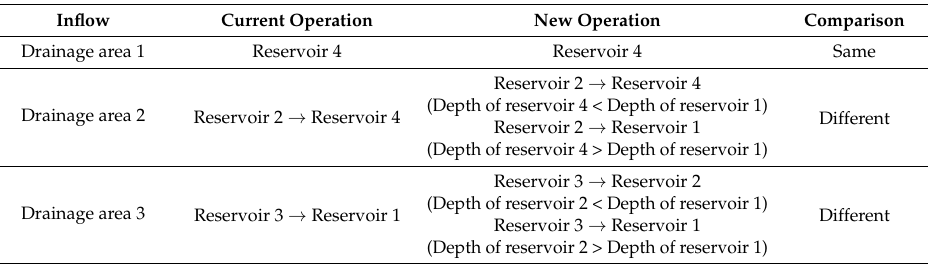
Table 2. Comparison between the current and new operations with